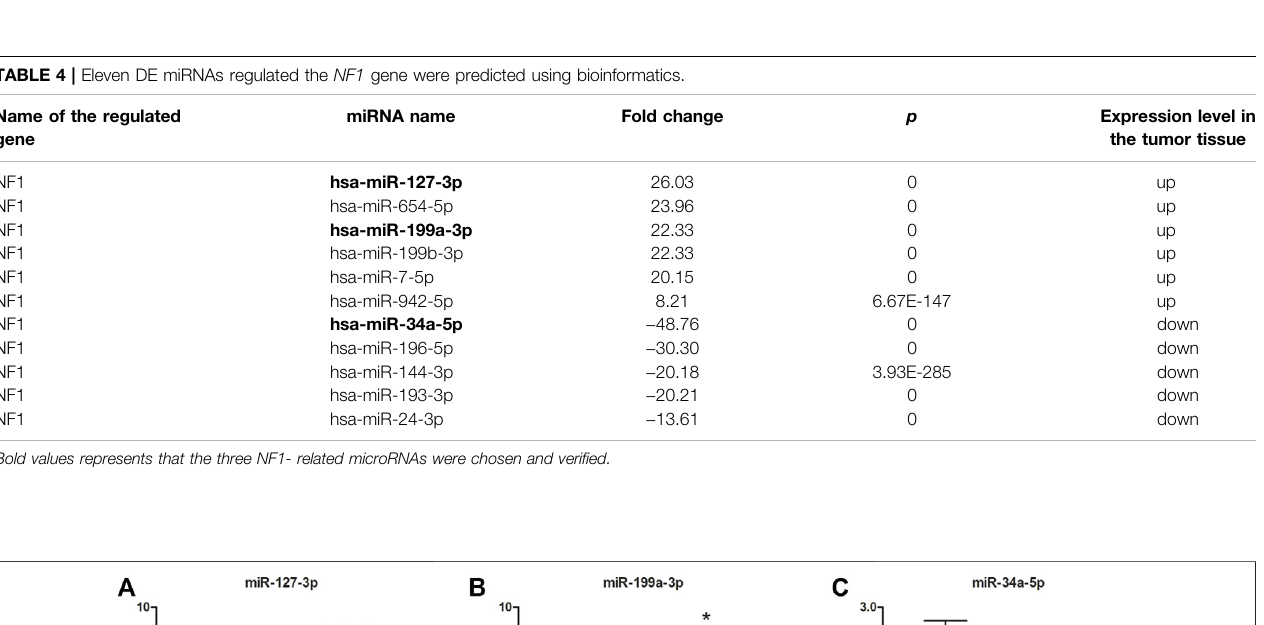
TABLE 4 | Eleven DE miRNAs regulated the NF1 gene were predicted using bioinformatics. Name of the regulated gene